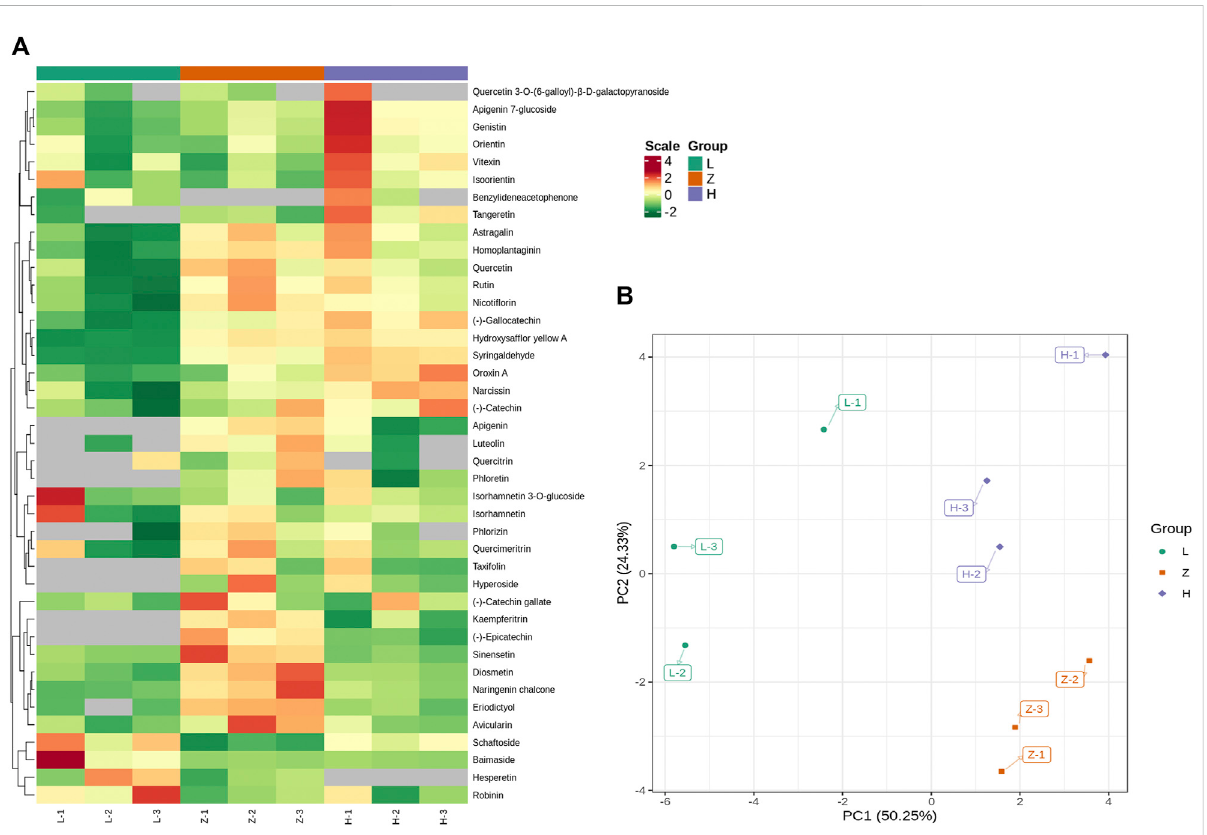
FIGURE 4 Differentialaccumulationof fl avonoidsinthreeleaftissues,L(greenleaves),H(Yellowleaves),andZ(purpleleaves). (A) accumulationpatternof 41 DAFs(at leastdifferentiallyexpressedinone comparison). (B) PCA plotdepicting PC-based distributionofsamplesand their replicates. L,H,and Z correspond to green, yellow, and purple leaves. The numbers 1, 2, and 3 correspond to each